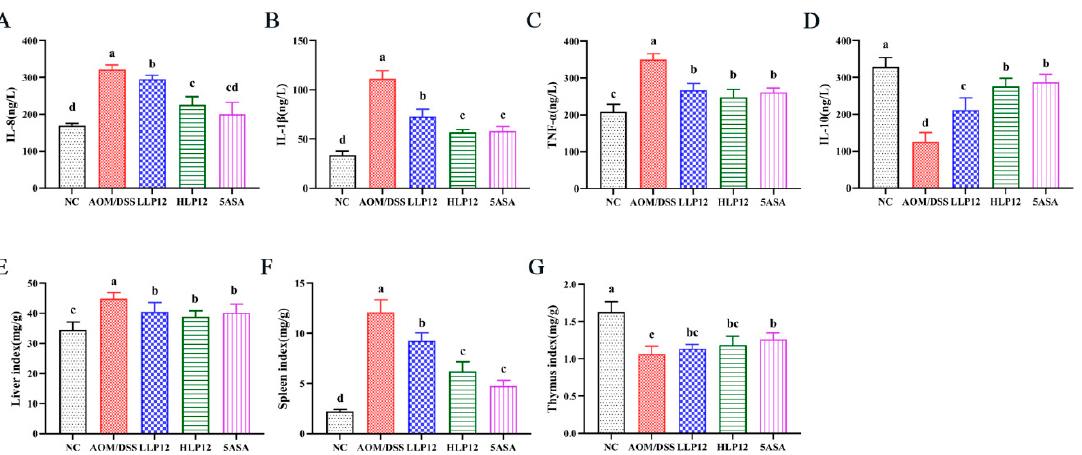
Figure 3. Effect of L. plantarum -12 oral administration on inflammatory cytokine and organ index of the AOM/DSS-treated C57BL/6 mice ( n = 4). ( A ) IL-8, ( B ) IL-1 β , ( C ) TNF- α , ( D ) IL-10, ( E ) liver index, ( F ) spleen index, and ( G ) thymus Index. The data with different lowercase letters are significantly different ( p <